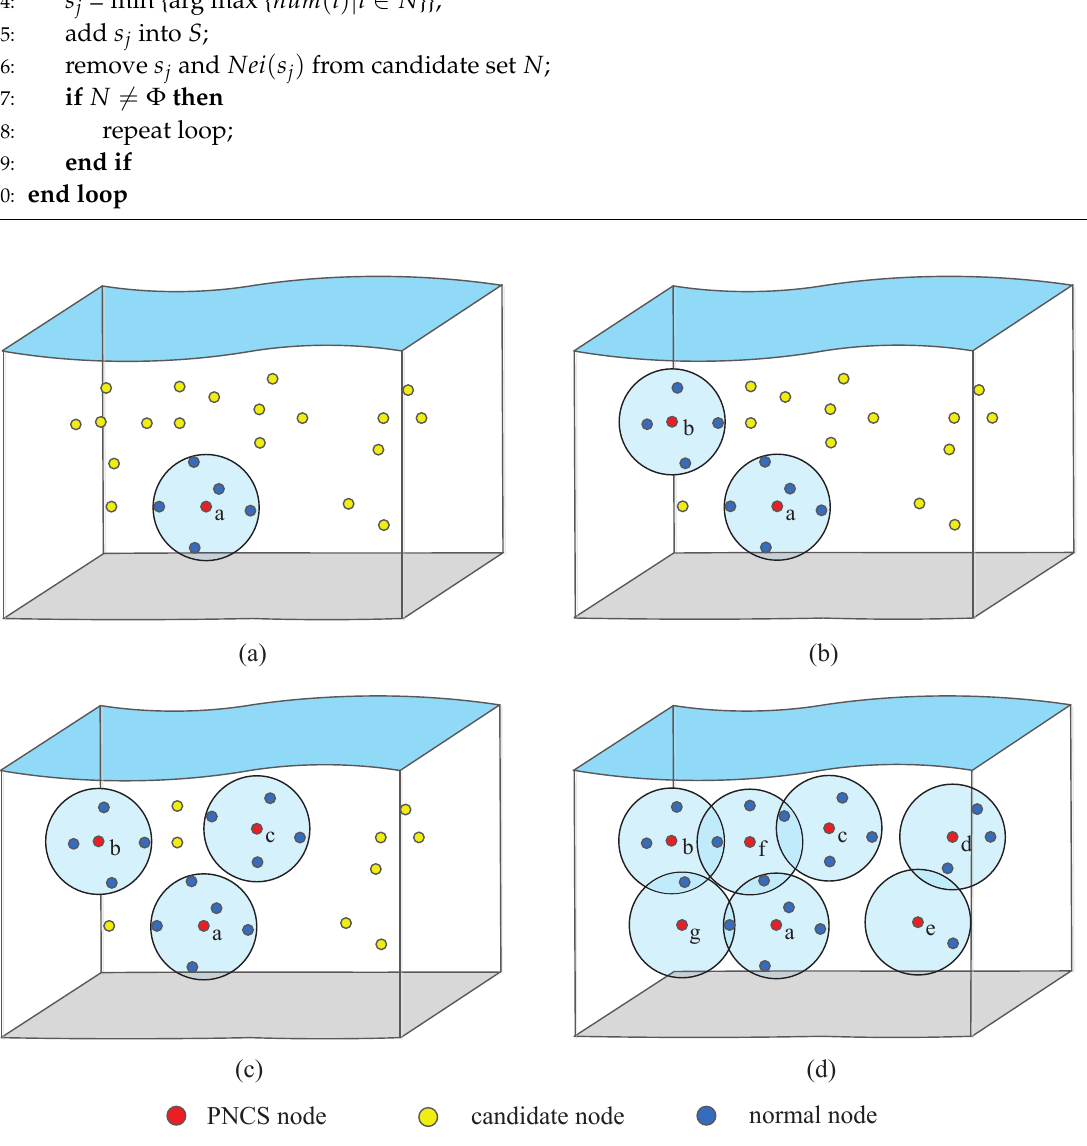
Figure 6. An example of PNCS construction ( a ) The first PNCS node selection; ( b ) The second PNCS node selection; ( c ) The third PNCS node selection; ( d ) The final PNCS